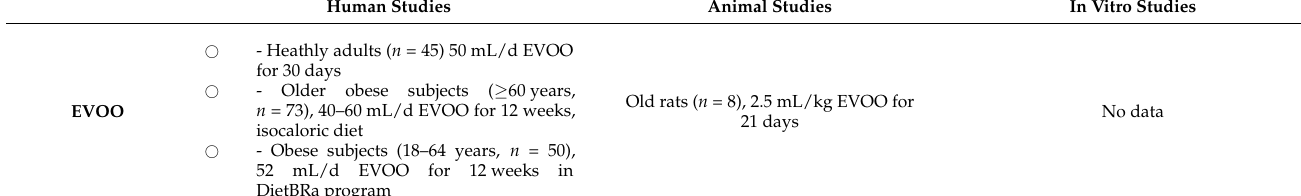
Table 1. Human, animal and cell studies have been schematized to highlight the sample size ( n ), the dosage end the time of administration of EVOO, Oleuropein, Hydroxytyrosol and Tyrosol. Human Studies Animal Studies In Vitro